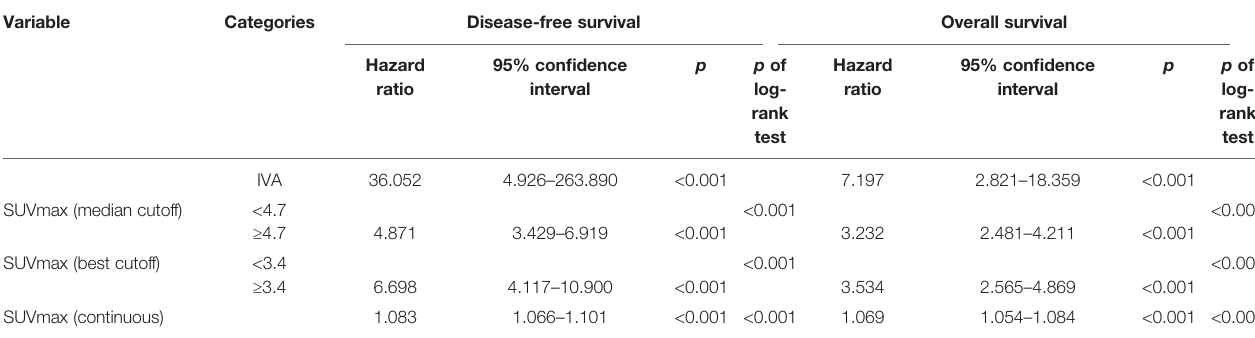
TABLE 3 | Multivariate Cox regression analysis of disease-free survival in esophageal squamous cell carcinoma. Variable Categories 7th-edition staging, SUVmax (median